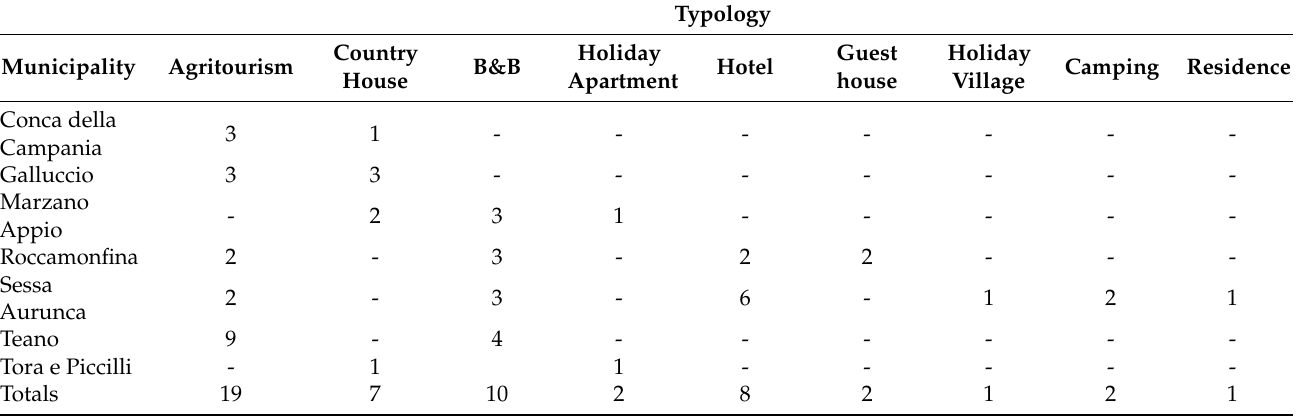
Table 5. Accommodation facilities in Regional Park area of the volcanic area of Roccamonfina and the Garigliano